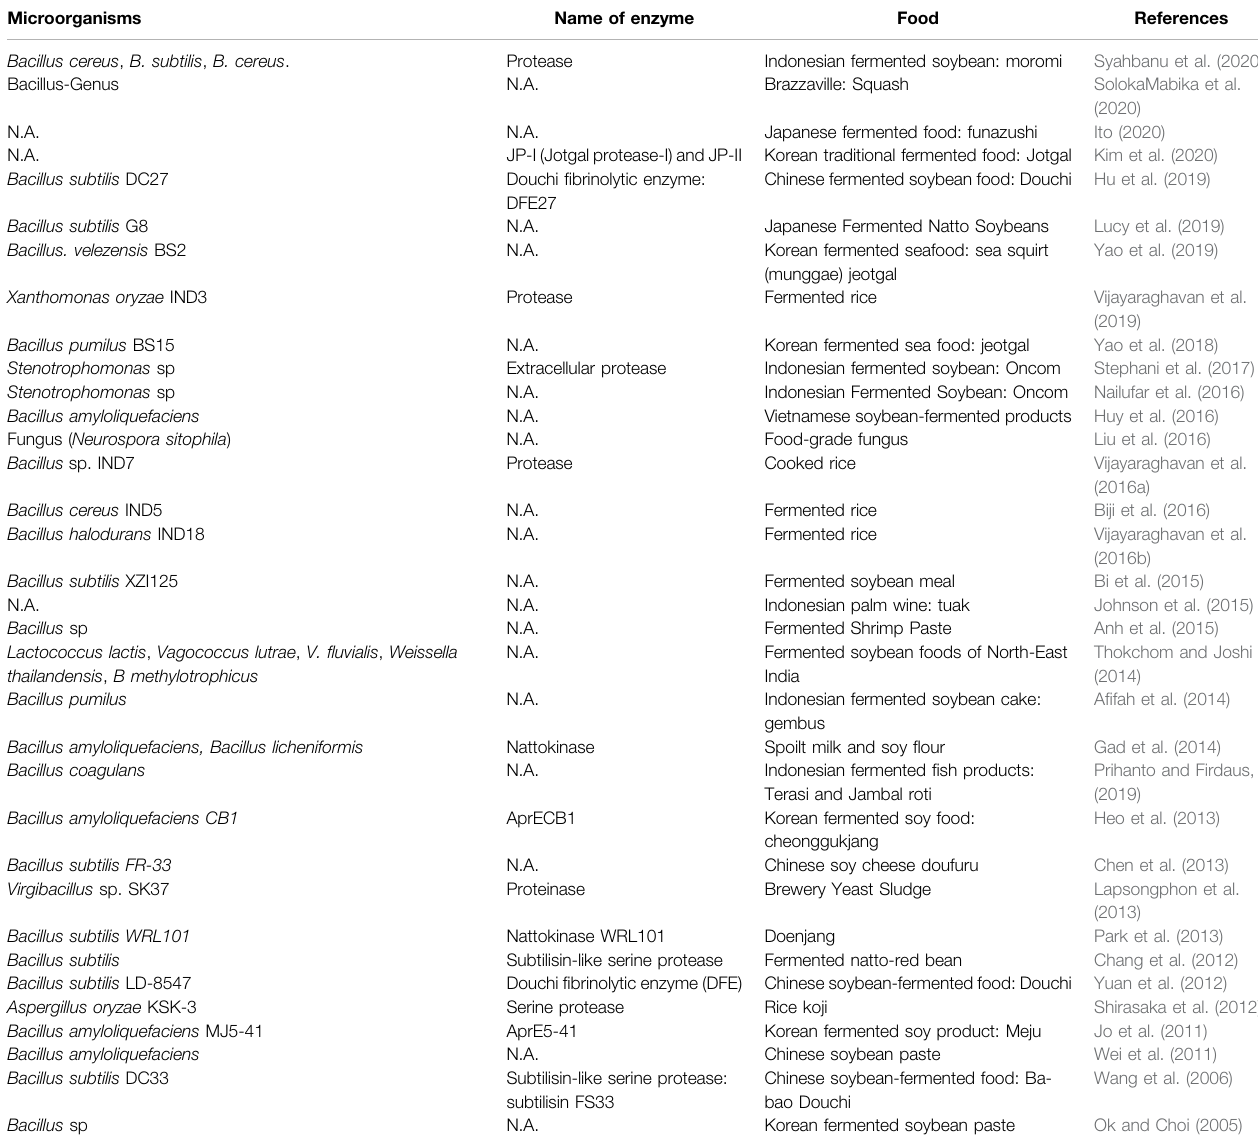
TABLE 4 | Fibrinolytic enzymes from microorganisms food products. Microorganisms Name of